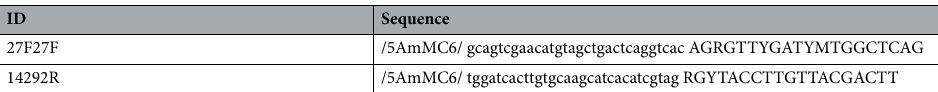
Table 2. Primers for cyanobacterial 16S rRNA gene amplification and sequencing. *Lowercase = Universal sequence for the library construction, *Uppercase = Designed sequence for 16S